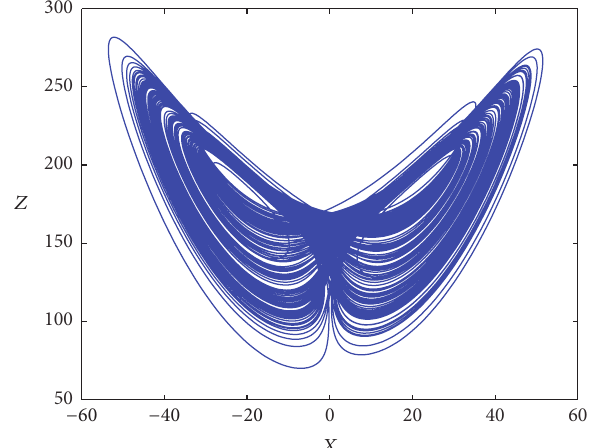
Figure 1: XZ composition of the Lorenz system solution for {𝜎 = 10 , 𝜌 = 178 , and 𝛽 = 8/3}